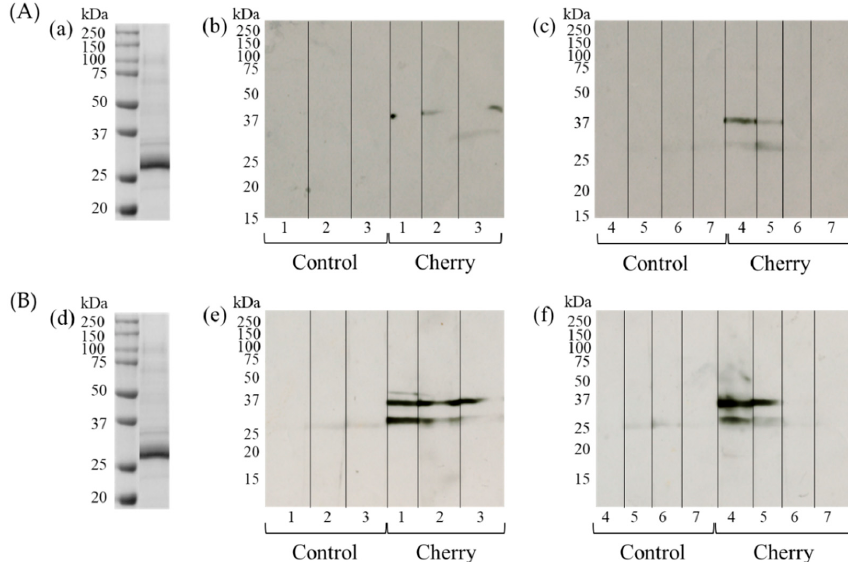
Figure 3. Detection of IgE-binding ( A ) and IgG1-binding ( B ) cherry proteins using immunoblotting. ( A ) ( a ) Coomassie brilliant blue staining of cherry proteins. ( b , c ) Immunoblotting using cherry proteins, individual mice sera, and HRP-labeled antimouse IgE antibody. The numbers indicate the individual mice in control and cherry groups. Molecular mass was standed for kDa. ( B ) ( d ) Coomassie brilliant blue staining of cherry proteins. ( e , f ) Immunoblotting using cherry proteins, individual mice sera, and HRP-labeled antimouse IgG1 antibody. The numbers indicate the individual mice in control and cherry groups. No specific bands were detected higher and lower areas than 15–250 kDa areas in sera from mice in both groups (data not shown).